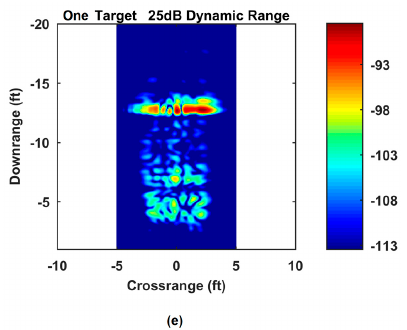
Figure 17. Images of a single target 3.96 m (13 feet) down-range over 5–25 dB image dynamic range using SVD: ( a ) 5 dB; ( b ) 10 dB; ( c ) 15 dB; ( d ) 20 dB; ( e ) 25 dB.